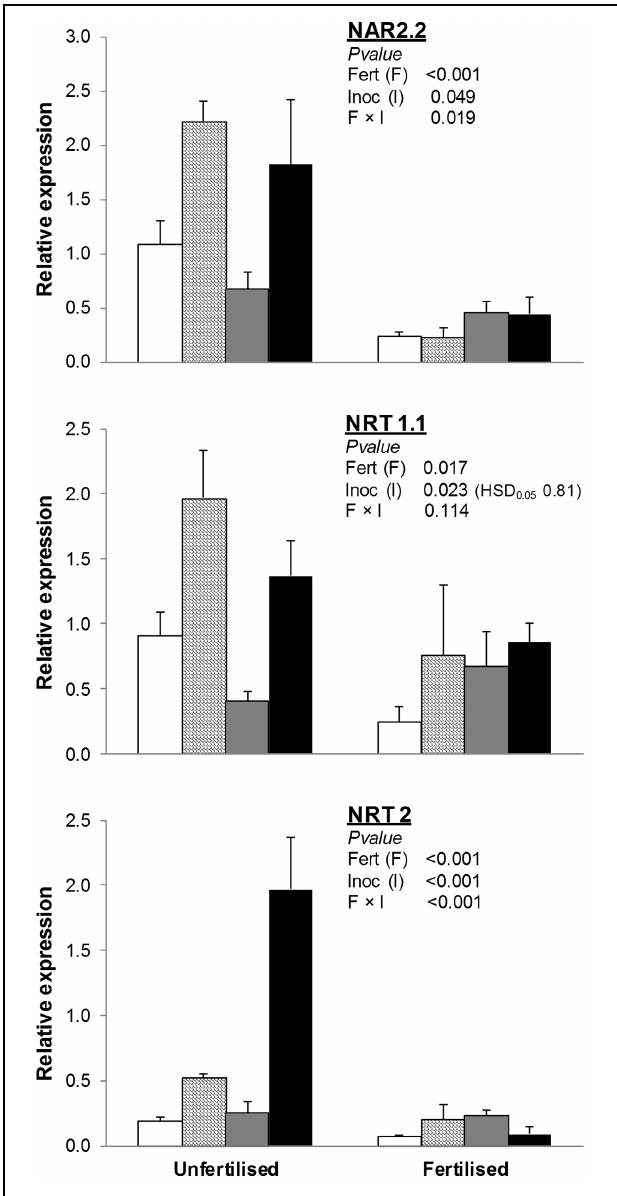
FIGURE 2 | Expression of nitrate transporter genes ( NAR2.2, NRT1.1, NRT2 ) in T. durum root. Plants were grown under the unfertilized conditions or fertilized with an organic fertilized with low C:N ratio. Soil was left with the NAT (white bars); inoculated with only AMF spores (scaled bars); only plant PGPR (gray bars), or both AMF + PGPR (black bars). Means ( n = 6) with standard errors and analysis of variance results are shown. Fert is for fertilization treatment, Inoc for Inocula. Tukey’s HSD 0 . 05 of Inocula is shown when Inocula, but not Fertilizer × Inocula interaction, is significant. strongly increased its expression compared to NAT and PGPR, respectively ( Figure 2 ).